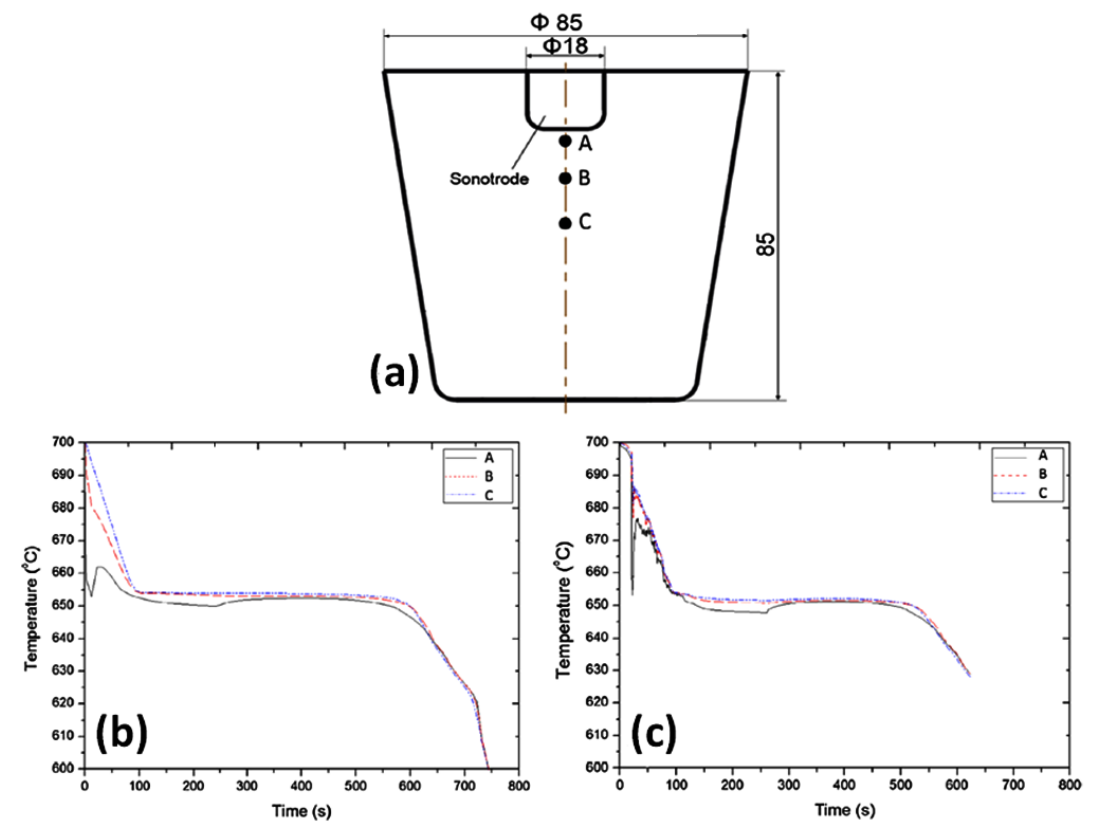
Figure 4. ( a ) Schematic of the casting setup shows the locations of points (A, B, C) and the simulated cooling curves of an Al-2Cu alloy when ( b ) the sonotrode is immersed into the melt but is not turned on during solidification and ( c ) the sonotrode is turned on before immersion into the melt and remains on during solidification as detailed in [38]